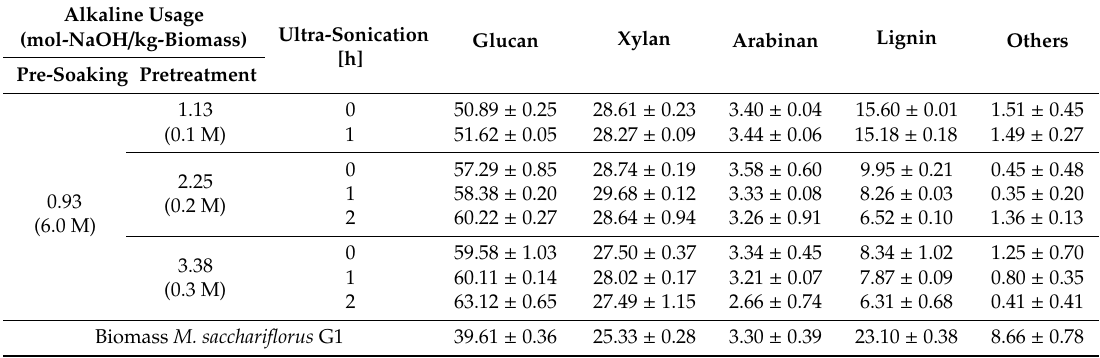
Table 1. Compositional analysis of alkaline-ultrasonic pretreated M. sacchariflorus G1 (wt.%). Alkaline Usage (mol-NaOH / kg-Biomass) Ultra-Sonication Glucan Xylan Arabinan Lignin Others [h] Pre-Soaking